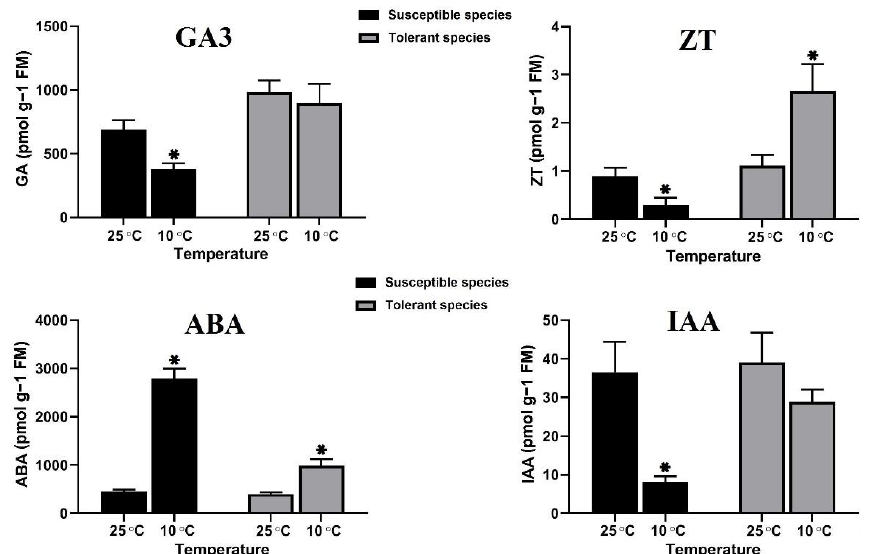
Figure 1. Hormone content profiles, including abscisic acid (ABA), indole-3-acetic acid (IAA), gibberellin (GA3), and zeatin (ZT) contents, in tomato leaves in response to temperature change (10 °C for three days). An asterisk above a bar shows a significant difference ( p -value < 0.05) between the low-temperature and normal-temperature treatments ( n = 4) (according to Student’s t -test). Table 2. Correlation between hormones in susceptible species (below the diagonal) and tolerant species (above the diagonal) under normal and low-temperature conditions.